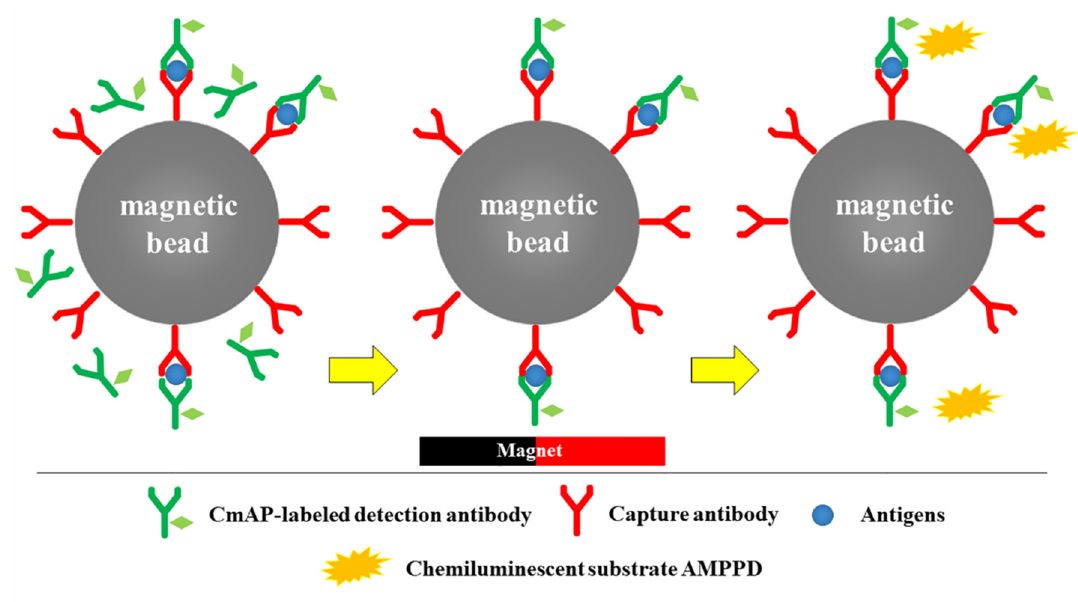
Figure 1. Schematic illustration of the magnetic beads-based chemiluminescence immunoassay (MPs- CLEIA).